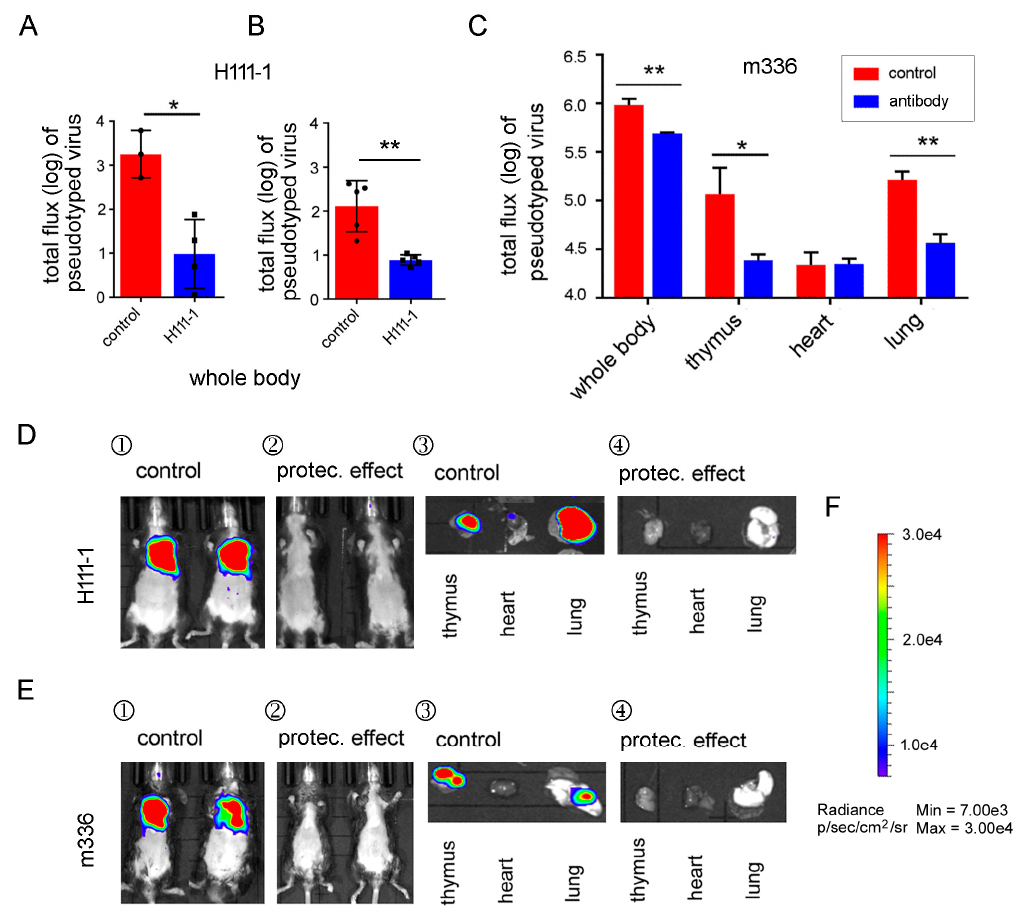
Figure 6. Inhibition of pseudotyped MERS-CoV infection in R26-hDPP4 mice by the novel mAb H111-1 and the well-characterized mAb m336. For evaluation of H111-1, mice were administered 1 mg/kg of mAb either I.P. ( A ) or I.T. ( B ) and 6 h later, challenged with pseudovirus I.T. at a dose of 3.8 × 10 6.5 TCID 50 . On day 11 p.i., BLI of the whole body or specific organs was conducted ( D ). To evaluate the efficacy of m336 ( C ), mice were administered mAb and challenged using the same doses as for H111-1, and typical images ( E ) are shown. ( F ) Bar of photo flux; for details see Figure 2. N = 4 mice in each group, * means p < 0.05, ** means p <